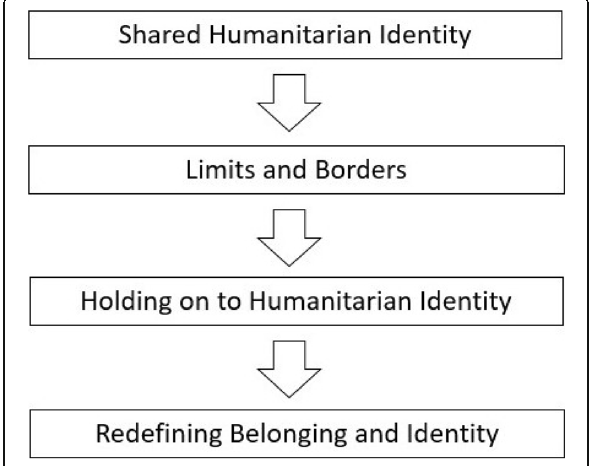
Fig. 1 Humanitarian workers ’ understanding of belonging